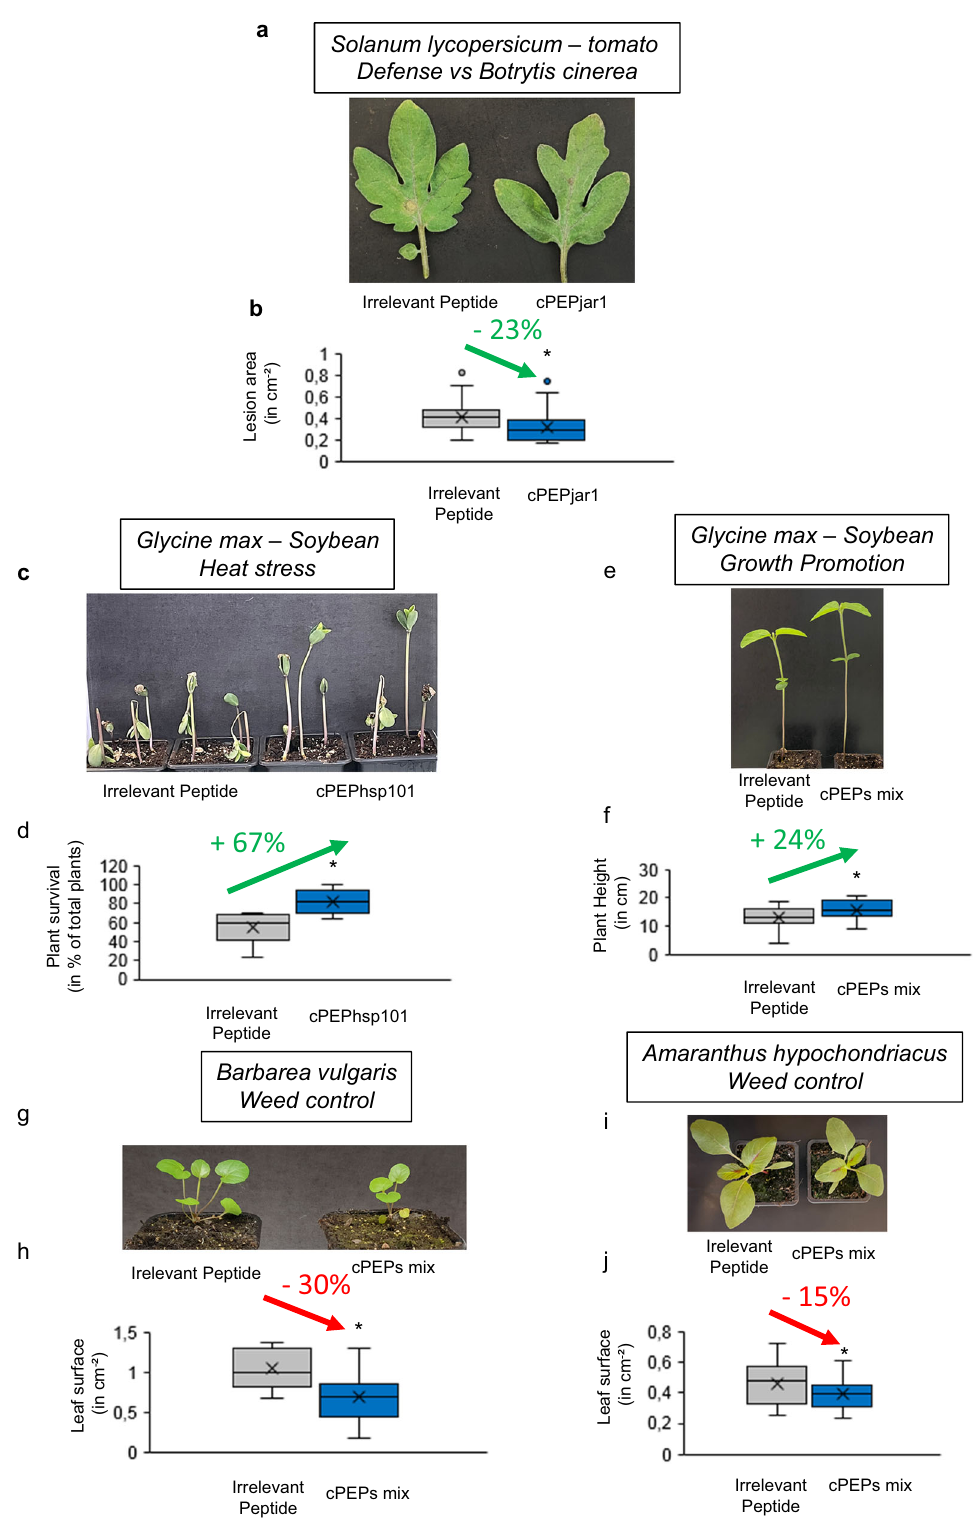
Fig. 5 | cPEPs are useful tools in agronomy. a , b Relative lesion area of S. lyco- persicum leaves infected with B. cinerea and treated with an irrelevant peptide or cPEPjar1. c , d Resistance to heat stress of soybean plants treated with an irrelevant peptideorcPEPhsp101. e , f Growth(plantheight)ofsoybeanplantstreatedwithan irrelevantpeptideoramixtureofcPEPs(targetingMRB1,SHY2,andSGR1). g , h Leaf surfaceof B.vulgaris plantstreatedwithanirrelevantpeptideoramixtureofcPEPs (targetingEIN2,BRI1,BAK1,andWUS). i , j Leafsurface,of A.hypochondriacus plants treatedwithanirrelevantpeptideoramixtureofcPEPs(targetingEIN2,BRI1,BAK1,